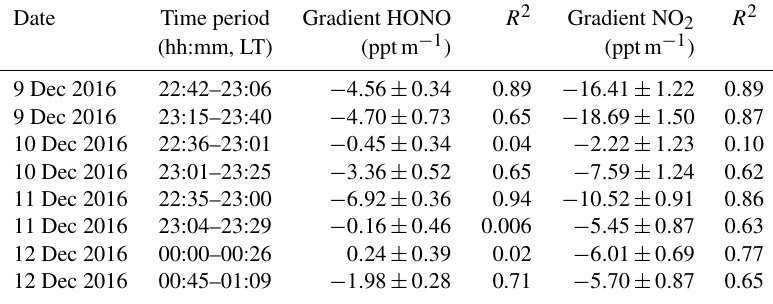
Table 2. The nocturnal gradient of HONO and NO 2 throughout the vertical measurements and the linear least squares regression slope and correlation coefficient of HONO and NO 2 to altitude identified in each vertical profile